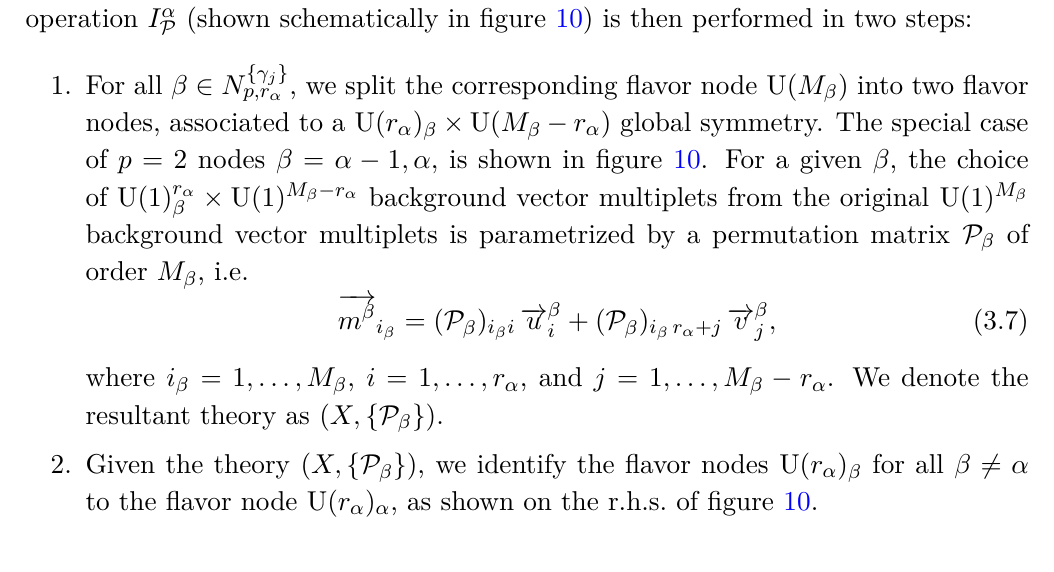
Figure 9 . A flavoring operation F α generic quiver gauge theory (represented by the grey